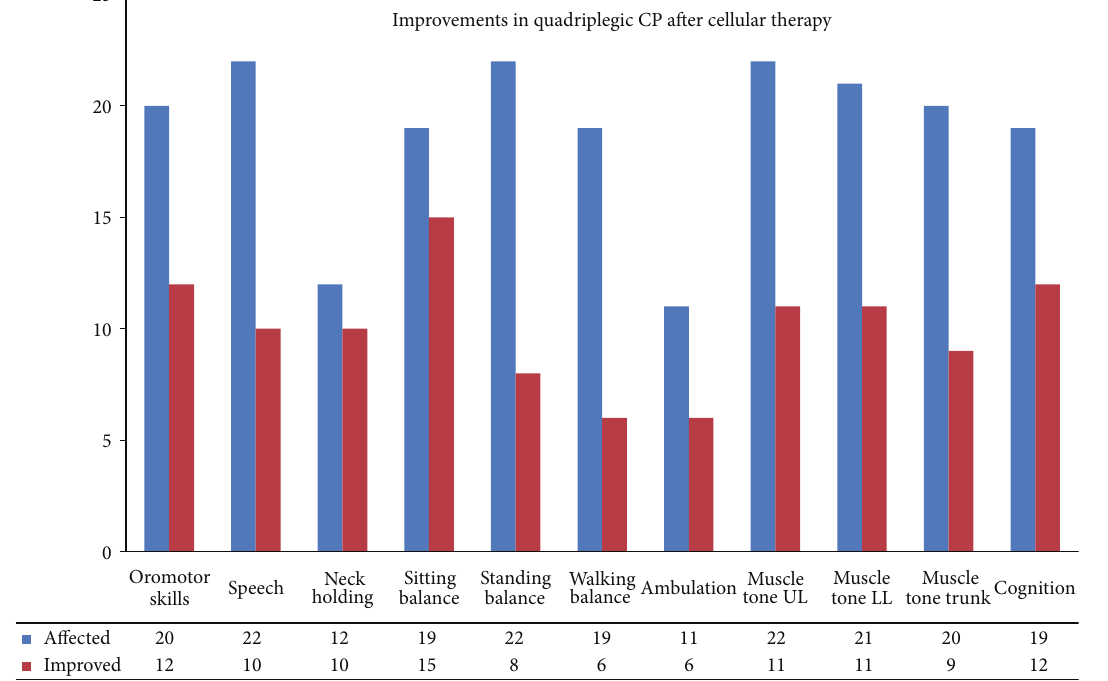
Figure 2: Improvements in quadriplegic CP: graph demonstrating symptomatic improvements in quadriplegic cerebral palsy after cellular